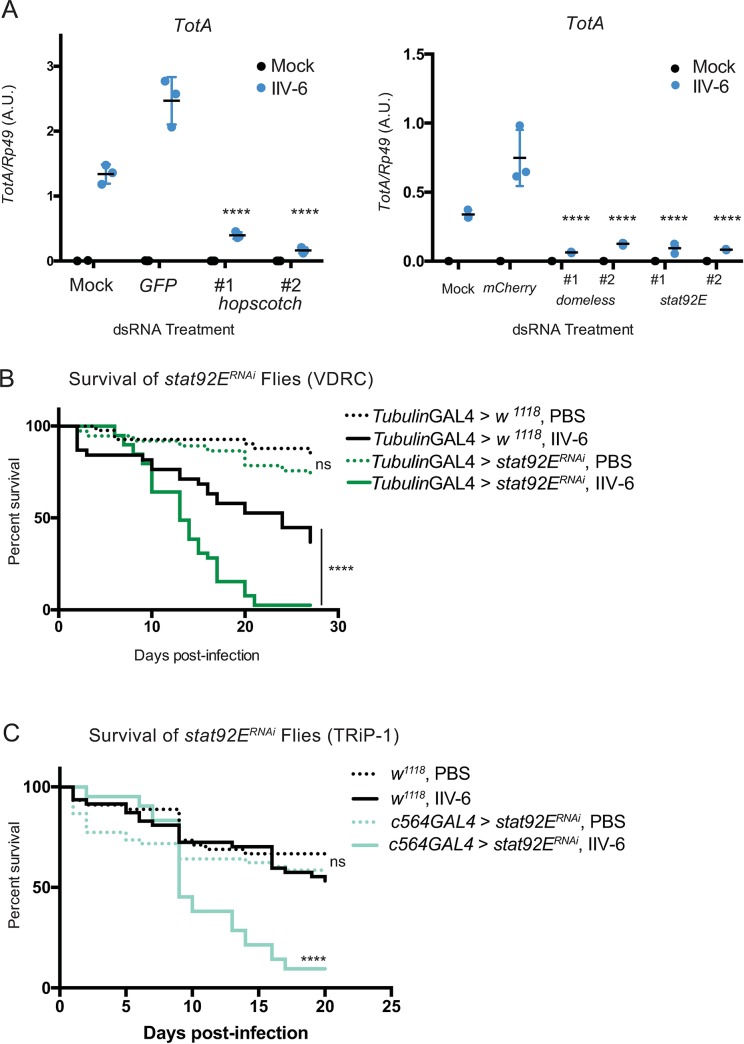
JAK-STAT signaling is required for IIV-6-induced turandot expression and survival from virus infection A) S2* cells were transfected with dsRNA targeting hopscotch, domeless, or Stat92E, and 48 hours later were infected with IIV-6 for 24 hours. RNA was then isolated and TotA induction was quantified by qRT-PCR. Data shown are from three biologically independent assays. Two non-overlapping dsRNAs were used to target each gene. Error bars indicate standard deviation and black bars indicate mean. Statistical analysis was performed comparing control dsRNA (GFP or mCherry) transfected cells to target gene knockdowns by two-way ANOVA with corrections for multiple comparisons using the Holm-Sidak method (**** p <0.0001). A.U., Arbitrary Units. B) Kaplan-Meier curves showing survival of Stat92ERNAi expressing (UAS-Stat92ERNAi (VDRC)x tubulin-Gal4) flies (green lines) or control (w1118
x tubulin-Gal4) flies (black lines) following infection with IIV-6 (solid lines) or injection with PBS (dotted lines). C) Kaplan-Meier curves showing survival of Stat92ERNAi expressing (UAS-Stat92ERNAi (TRiP-1)x c564-Gal4) flies (green lines) or control (w1118) flies (black lines) following infection with IIV-6 (solid lines) or injection with PBS (dotted lines). Survival assays utilized at least 50 animals per treatment in each trial and statistical significance was determined by Log-rank (Mantel-Cox) test, comparing IIV-6 infected RNAi lines to IIV-6 infected control animals, or PBS-injected RNAi lines to PBS-injected controls. ****p <0.0001.